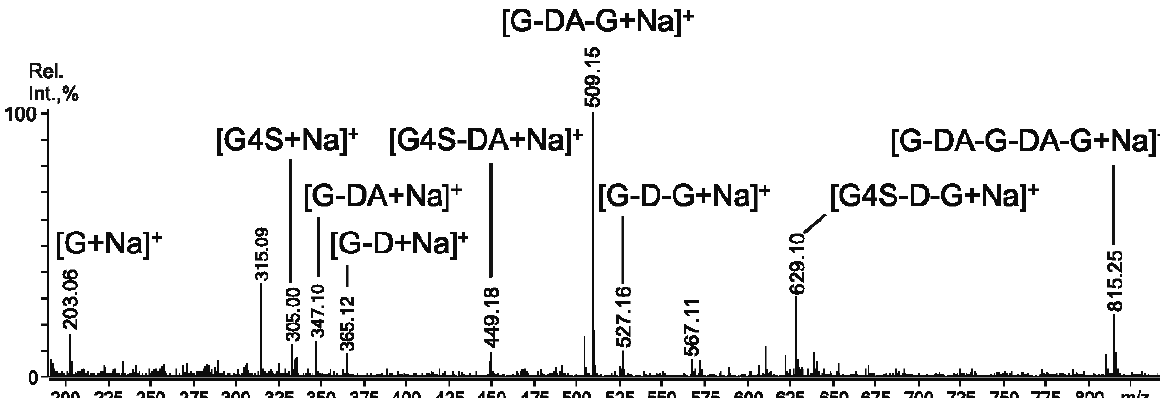
Figure 5. Positive-ion ESIMS of the oligosaccharide mixture, obtained through acid hydrolysis from RF/CRG polysaccharide.